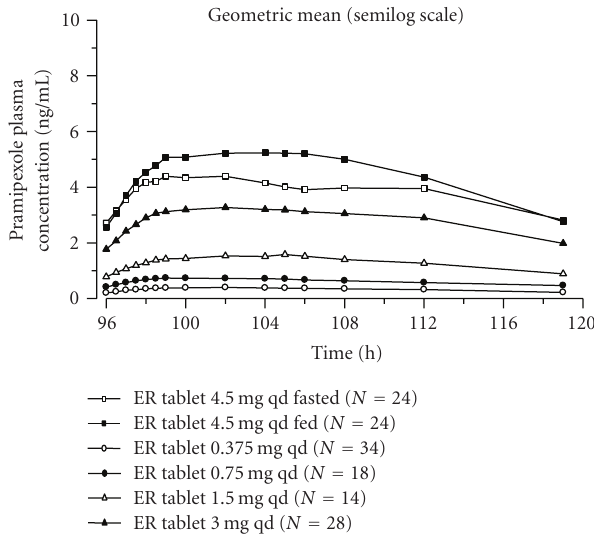
Figure 2: Geometric mean of the pramipexole plasma-concentra- tion time profile at steady state after intake of pramipexole ER (dose range: 0.375 mg to 3.0 mg/d)